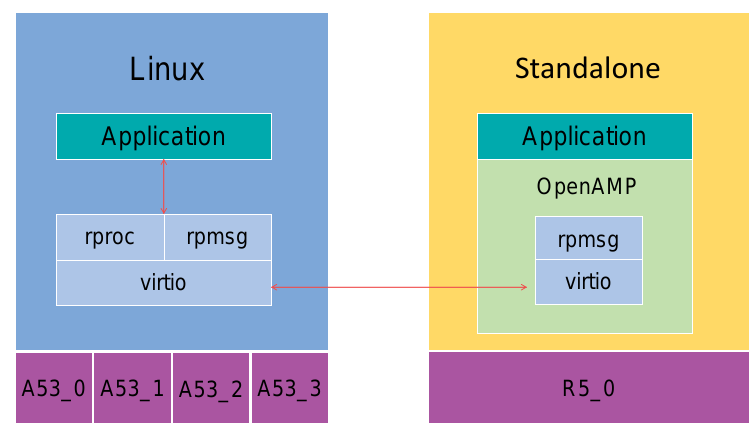
Figure 7. Scenario 4: standalone R5.